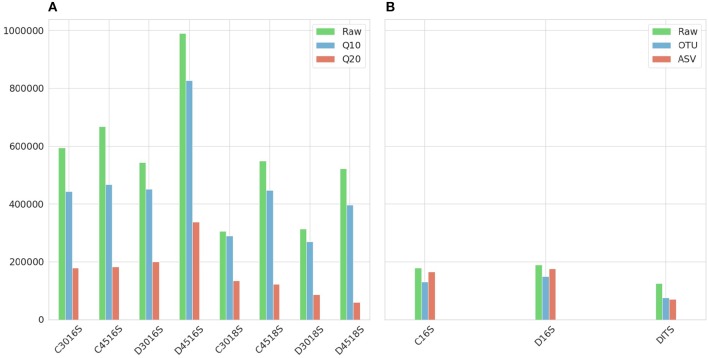
Number of sequences resulted after applying quality and chimeras filtering. (A) Ion Torrent. First letter of the sample names (C or D) represents type of mock community standard (Culture or DNA). What follows is the number of PCR cycles (30 or 45) with the amplicon (16S or 18S) at the end. The raw number of sequences are represented in green and in red and blue the two Phred33 quality filtering strategies Q20 and Q10, respectively. (B) Illumina. First letter of the sample names (C or D) represents type of mock community standard (Culture or DNA) with the amplicon (16S or ITS) at the end. The raw number of sequences are represented in green and in red and blue the sequences resulted from the filtering steps of the Illumina ASV and Illumina OTU pipeline, respectively.